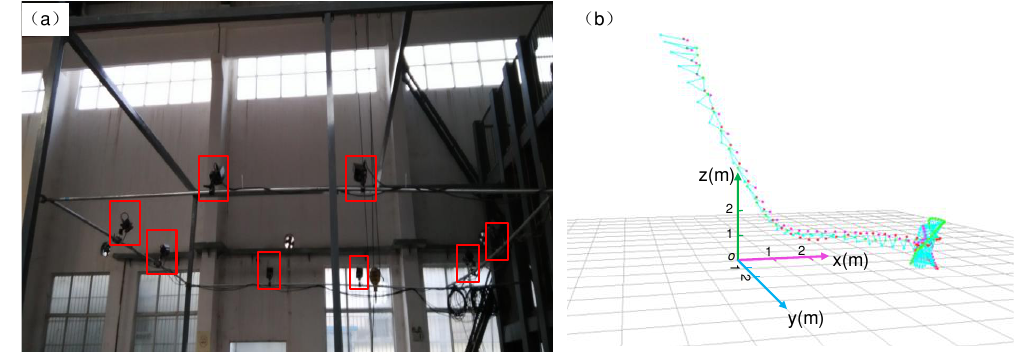
Figure 4. The data acquisition system: (a) eight infrared cameras used to capture the trails and (b) a motion analysis program used to provide the spatial motion